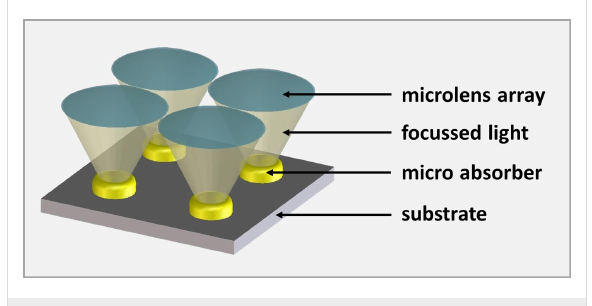
Figure 2: Scheme of the micro-concentrator solar cell